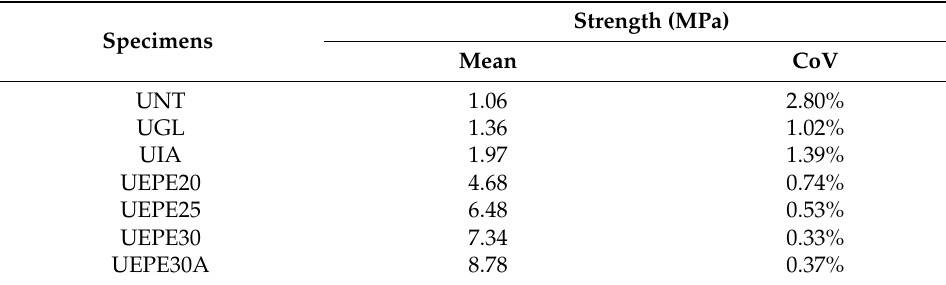
Figure 7. Measured load-deflection curves. Table 7. Flexural tensile strength of the